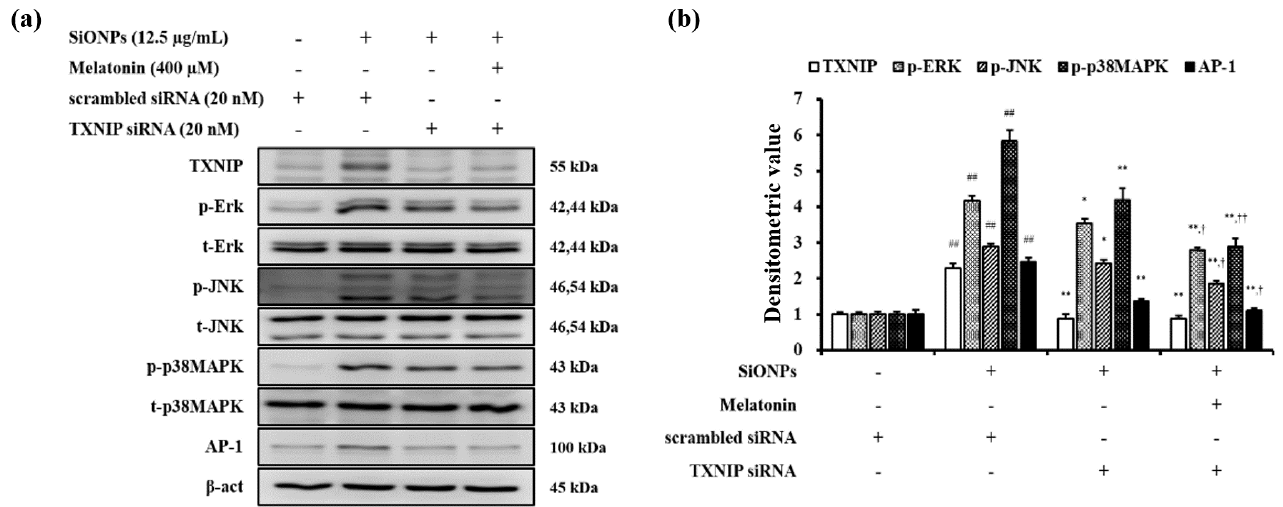
Figure 8. Melatonin suppressed inflammatory signalling in SiONPs-stimulated cells via TXNIP downregulation. ( a ) Representative figure for Western blot, ( b ) densitometric value. Densitometric expression value of each protein was quantified using Chemi-Doc (Bio-rad) ( n = 3). ## p < 0.01 vs. scrambled siRNA-transfected cells; * p < 0.05, ** p < 0.01 vs. SiONPs-stimulated cells; † p < 0.05, †† p < 0.01 vs. TXNIP siRNA-transfected cells stimulated by SiONPs.